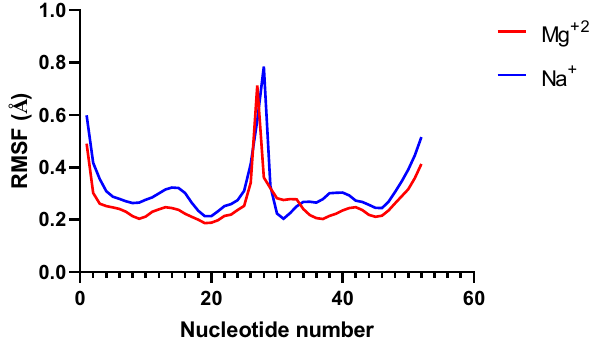
Figure 6. The root mean score fluctuation (RMSF) of siRNA in the presence of Mg 2+ ions and in the presence of monovalent ions. The siRNA is double stranded. Each chain of the siRNA has 23